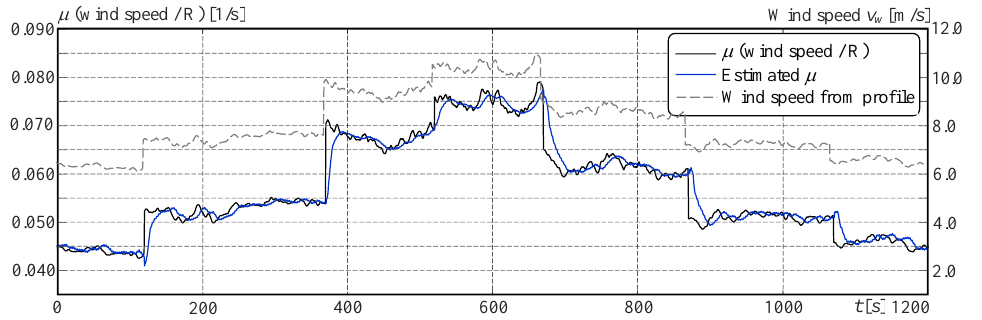
Figure 11. Relationship between λ and μ .